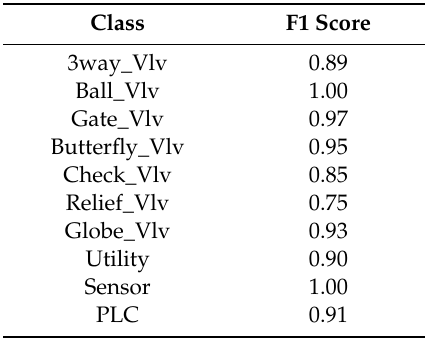
Table 4. F1 score for each class